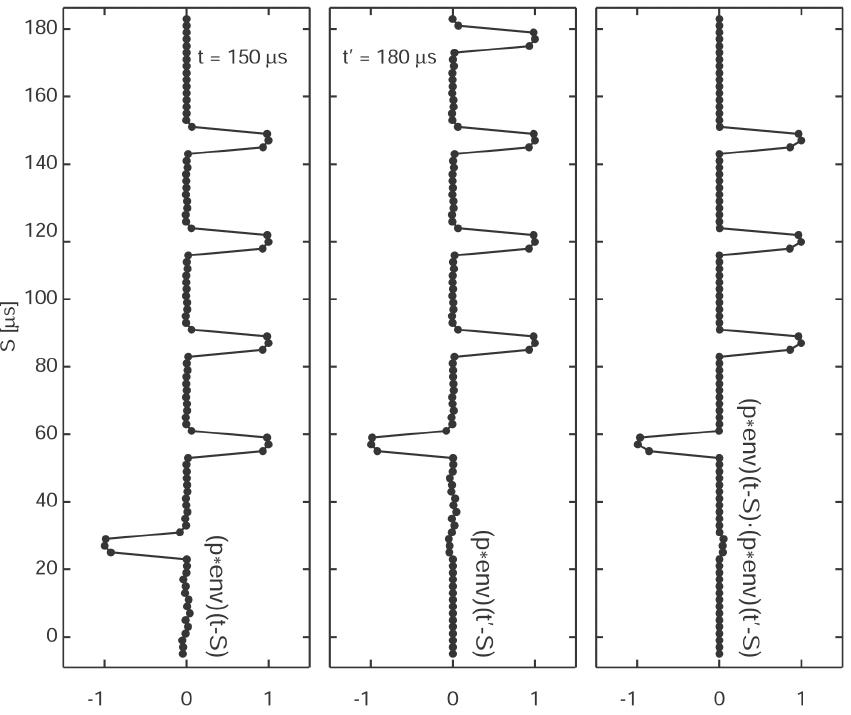
Fig. 3. Calculation of the range ambiguity function of 30- µ s lag for the 5-bit code. The left panel shows p ∗ env (t − S) and the middle panel p ∗ env (t 0 − S) , when t 0 − t = 30 µ s. Their product, which is the range ambiguity function, is plotted in the right-hand